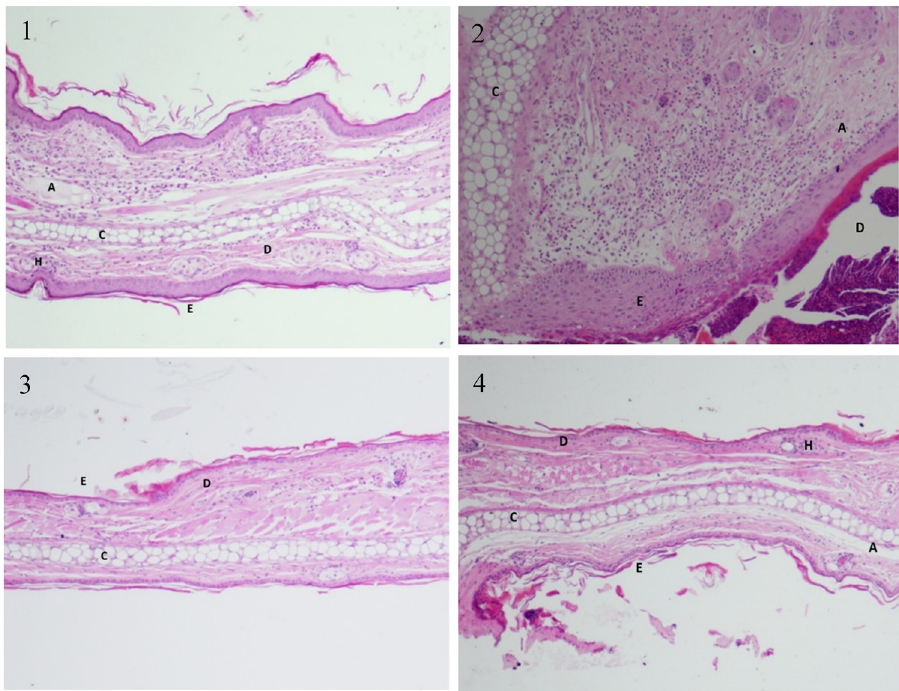
Figure 5: Hexane propolis extract reduced the histopathological alterations associated with ear in fl ammation/edema induced by croton oil. ( 1 ) Normal histological structures of the epidermal layer, dermal layer, and cartilage from an untreated ear. Note the absence of neutrophil in fi ltration. ( 2 ) Tissue treated with croton oil is showing in fi ltration of neutrophil in the dermis. ( 3 ) Tissue of ear treated with hexane propolis extract following croton oil showing virtually undamaged dermis and cartilage with little in fi ltration of cells. ( 4 ) Ear tissue treated with hexane propolis extract showing less of cells in the dermis compared to the croton oil - treated group. H, hair follicle; E, epidermis; D, dermis; C, cartilage; A, adipose